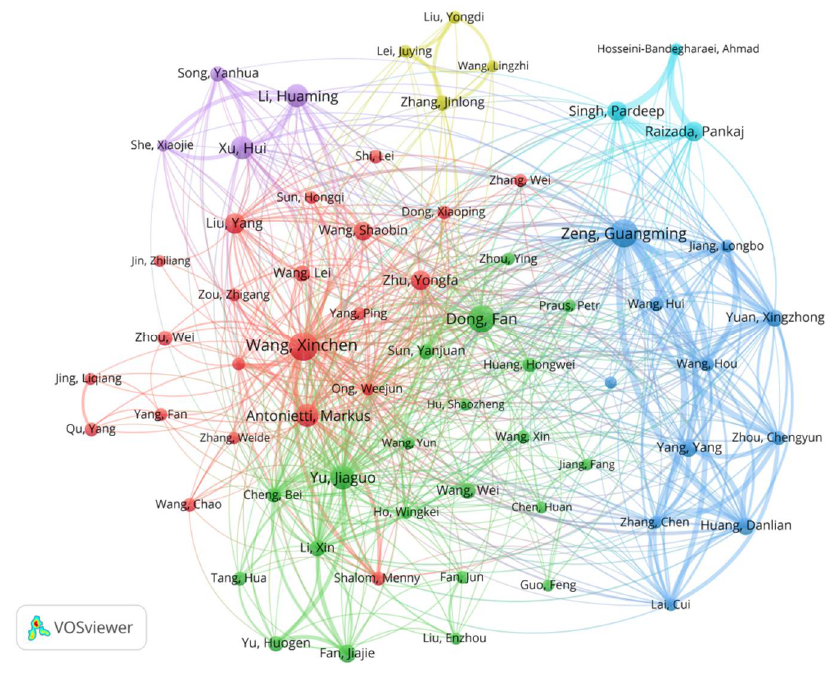
Figure 3. Authors collaboration network of photocatalytic applications of g-C 3 N 4 .